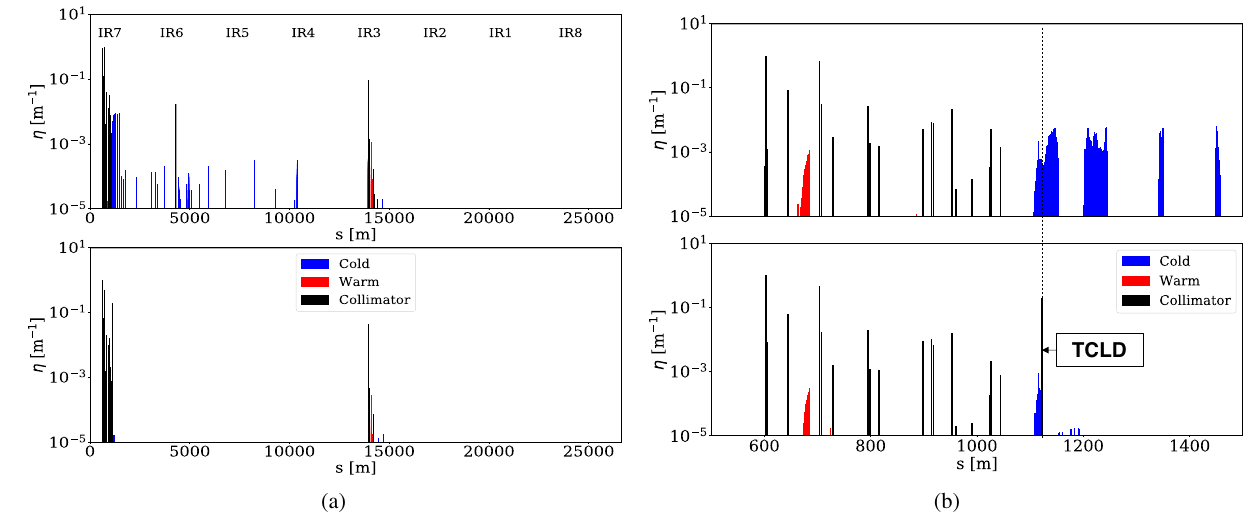
FIG. 18. Horizontal B2 full ring (a) and IR7 zoom (b) loss map for the LHC (top) and HL-LHC (bottom) 208 Pb 82 þ ion operation